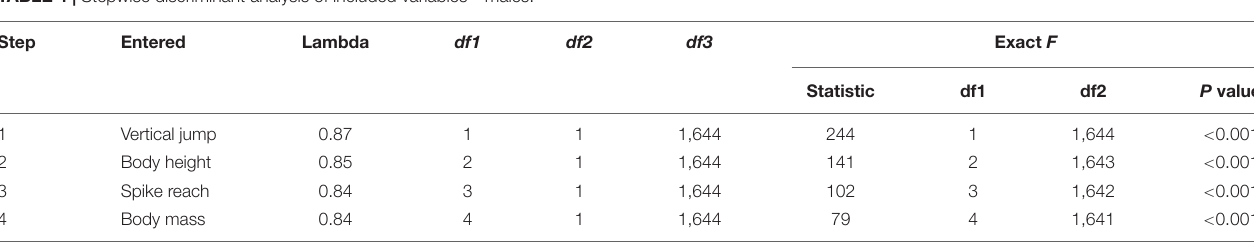
TABLE 4 | Stepwise discriminant analysis of included variables—males.